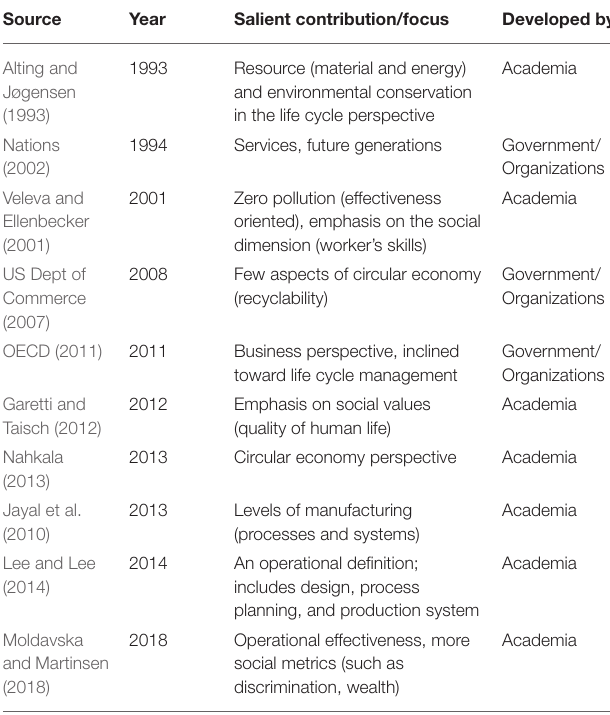
TABLE 3 | Analyzing definitions of Sustainable Manufacturing, extended from Kumar and Mani